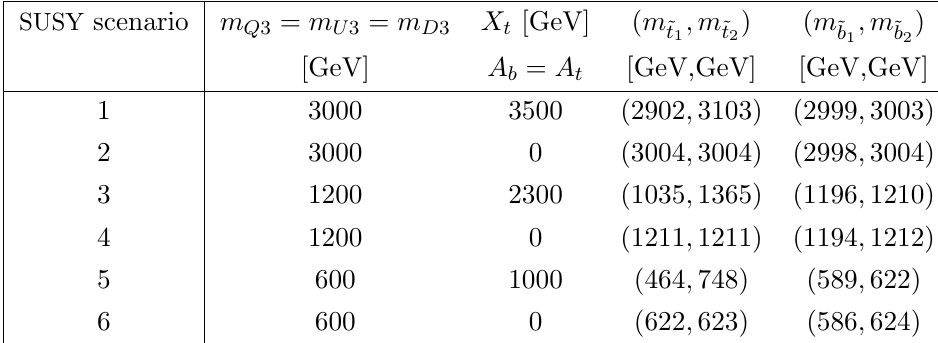
Table 17 . Choice of squark masses for the p T and M Z(cid:30) distributions shown in (cid:12)gure 8.